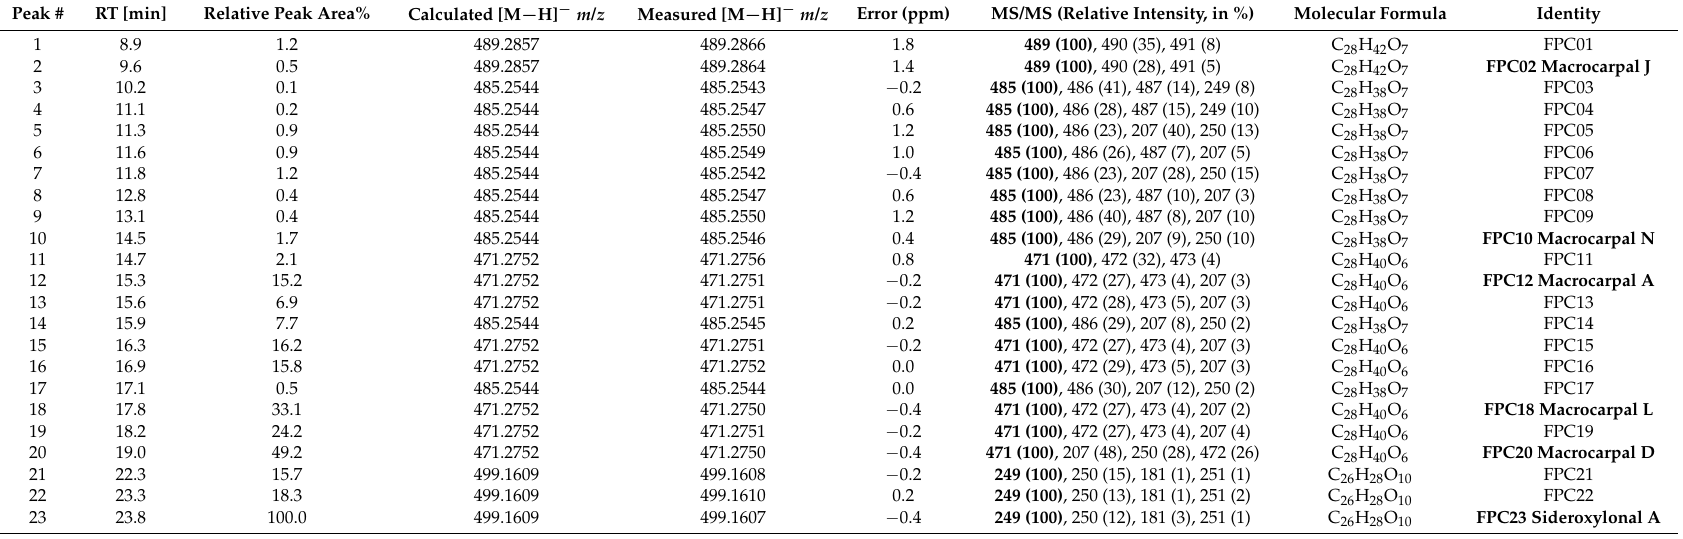
Table 1. Peak assignments of formylated phloroglucinol compounds (FPCs) detected in E. globulus leaves as analyzed by UHPLC-DAD-ESI-Q-TOF-MS/MS. Peak numbers shown in the table are presented as in Figure